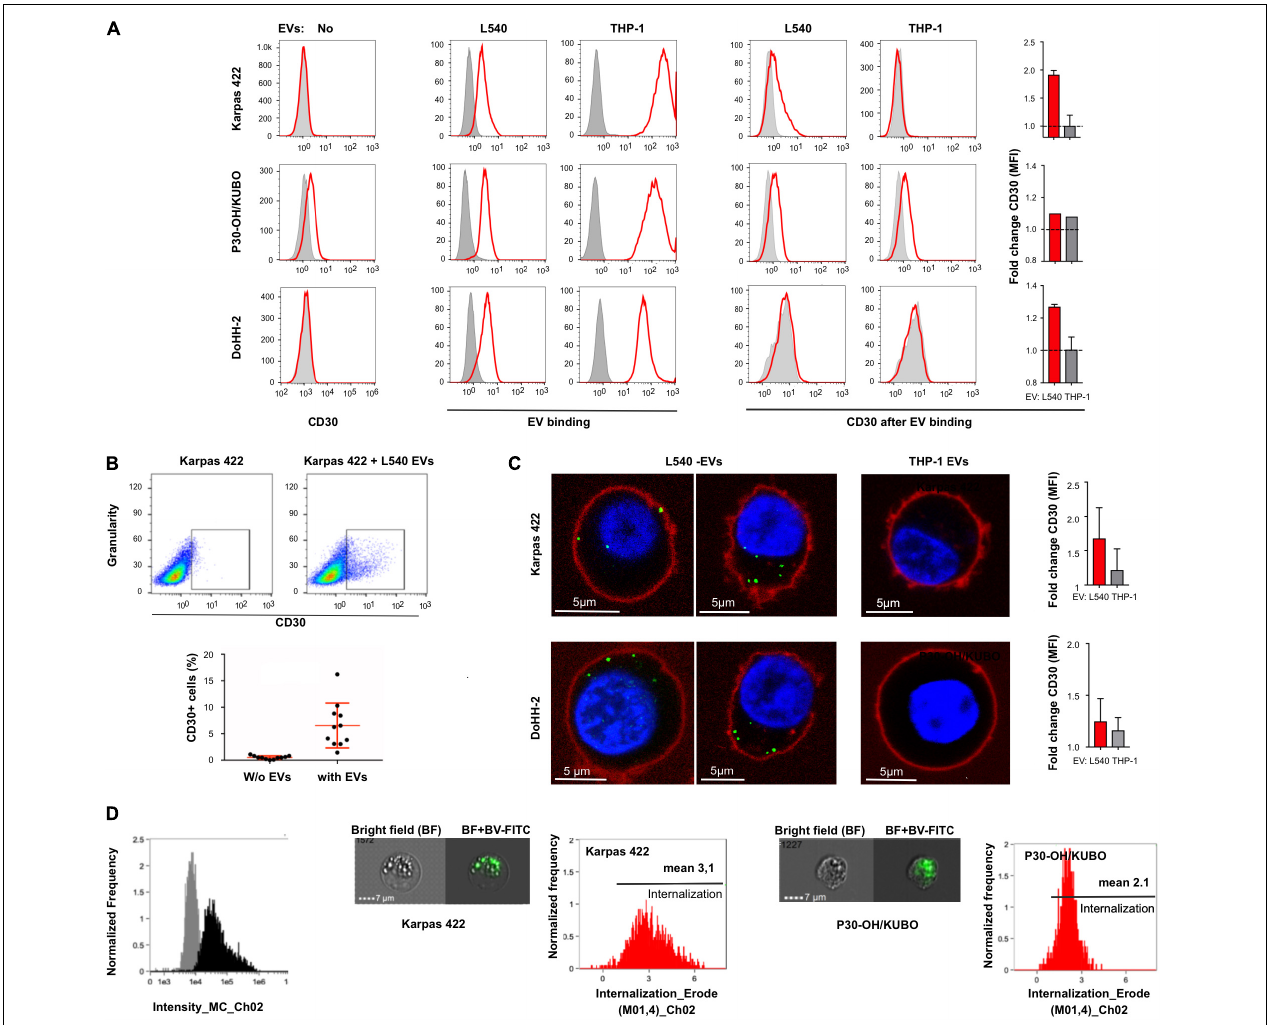
FIGURE 2 | Extracellular vesicle-dependent binding and incorporation of CD30 and BV. (A) The first column of graphs shows a flow cytometric analysis of the CD30 expression on the target cells Karpas 422, P30-OH/KUBO and DoHH-2 (red) compared to the isotype control (gray). The next two columns show the binding/uptake of purified EVs from the supernatant of L540 or THP-1 cells (red). For that, the cells were treated for 2 h at 4 ◦ C with DiD-labeled EVs. Untreated cells served as controls (gray). To the right, the two columns show the amount of CD30 after binding of EVs from L540 or THP-1 cells (red) as compared to the isotype control (gray). The adjacent bars indicate the relative increase of the CD30 mean fluorescence intensity (MFI) by the indicated EVs. (B) CD30 expression of Karpas 422 measured by flow cytometry, first gated on living cells and then the percentage of CD30 + cells was calculated with and without EVs; shown as a representative image without EVs (upper left) and with EVs (upper right) , and in a diagram summarizing the results of 11 measurements. (C) Confocal microscopy of Karpas 422 and DoHH-2 with L540 EVs (left panel) or THP-1 EVs (right) . Cells were incubated with Ki-3-CF594-loaded EVs and the cell membrane was subsequently stained with CellMask deep red. The fold change of CD30 expression after L540 and THP-1 EVs binding was measured by flow cytometry and normalized to the samples without EVs. (D) The internalization process was further analyzed by one imaging flow cytometry investigation. The specific intensity of the green fluorescence is depicted [ (left) , black]. Representative images are shown of Karpas 422 and P30-OH/KUBO cells, incubated with FITC-labeled SGN30 and EVs from L540 cells for 60 min at 37 ◦ C. Scale bars represent 7 µ m. Histograms displaying the internalization score are